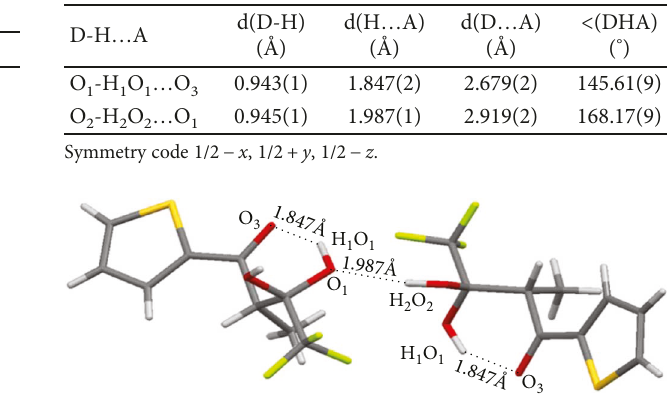
Figure 4: A packing diagram of 4,4,4-tri fl uoro-3,3-dihydroxy-2- methyl-1-(thien-2-yl)butan-1-one (3) showing the molecules linked by hydrogen bonds. Hydrogen bonds are shown as dashed puri fi cation. 1 H, 13 C, and 19 F spectra were acquired at 305 K